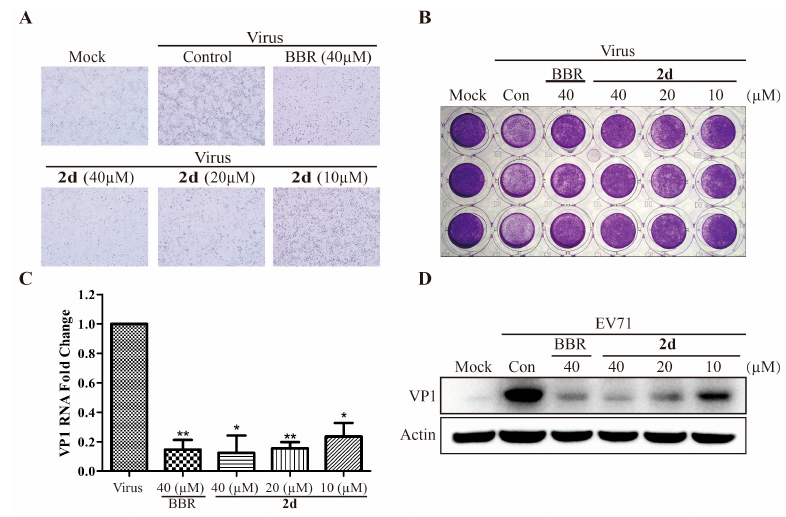
Figure 2. The anti-EV71 effect of compound 2d in Vero cells with BBR as a positive control. ( A ) 2d reduced the EV71-induced CPE. Cells were examined using a microscopy ( × 40); ( B ) 2d reduced the EV71-induced CPE. Cells were examined using crystal violet staining; ( C ) 2d reduced the expression of EV71 VP1 RNA by one-step qRT-PCR assay. ** p < 0.001 * p < 0.05; ( D ) 2d reduced the expression of EV71 VP1 protein by western blot assay.